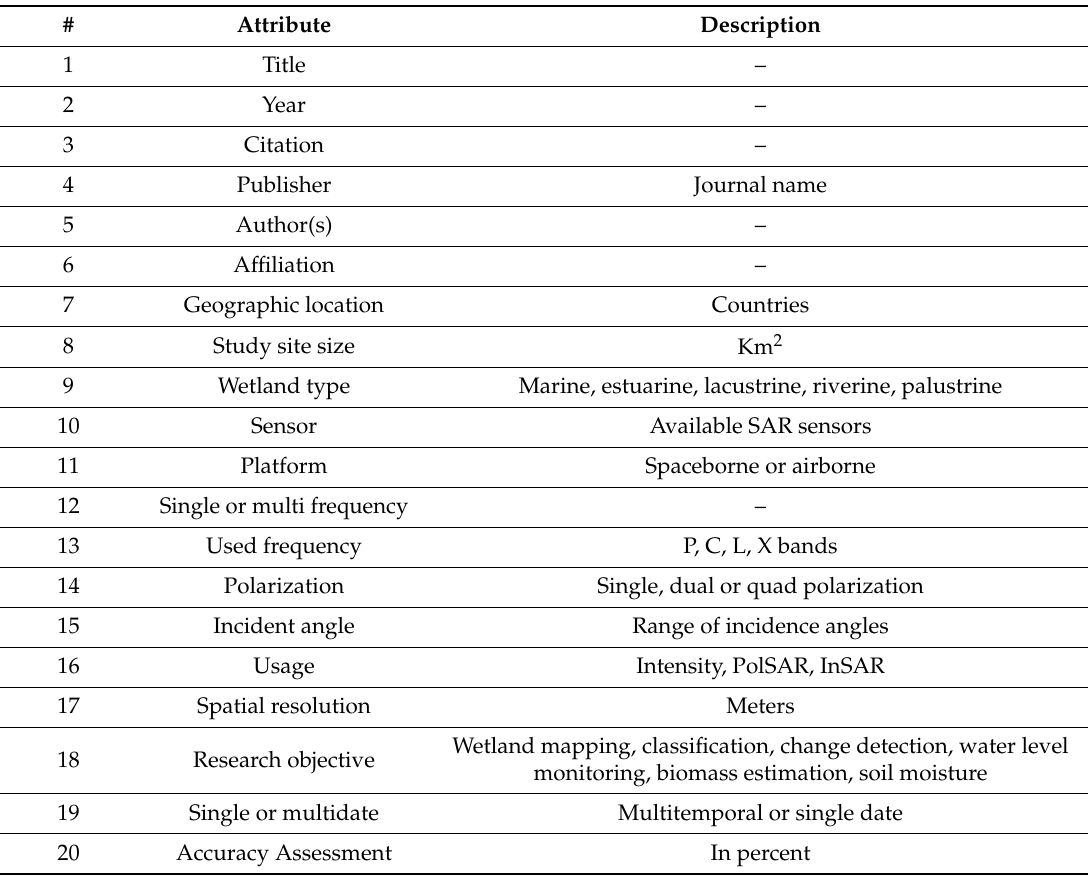
Table 1. Attributes extracted from screened articles in database for systematic meta-analysis. These attributes were imported into an excel sheet for further